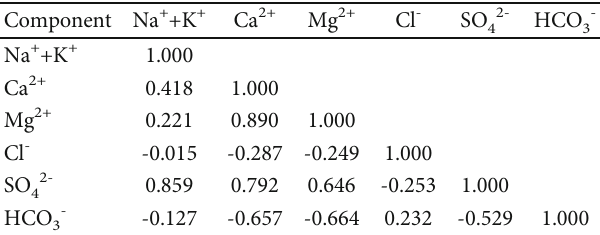
Table 5: Result of correlation analysis.